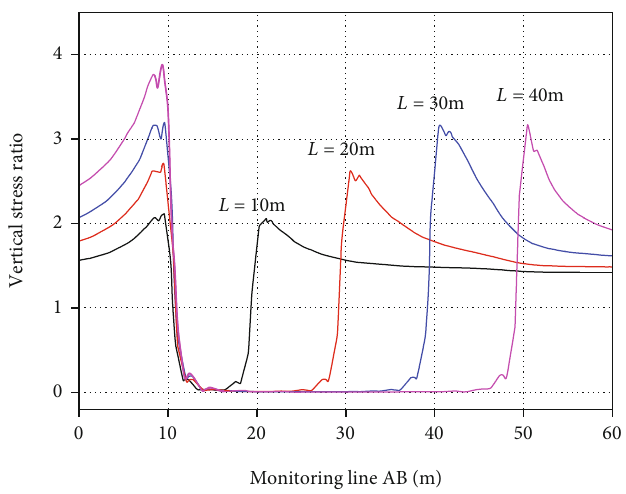
Figure 3: Variation trend of vertical stress ratio in monitoring line A-B.